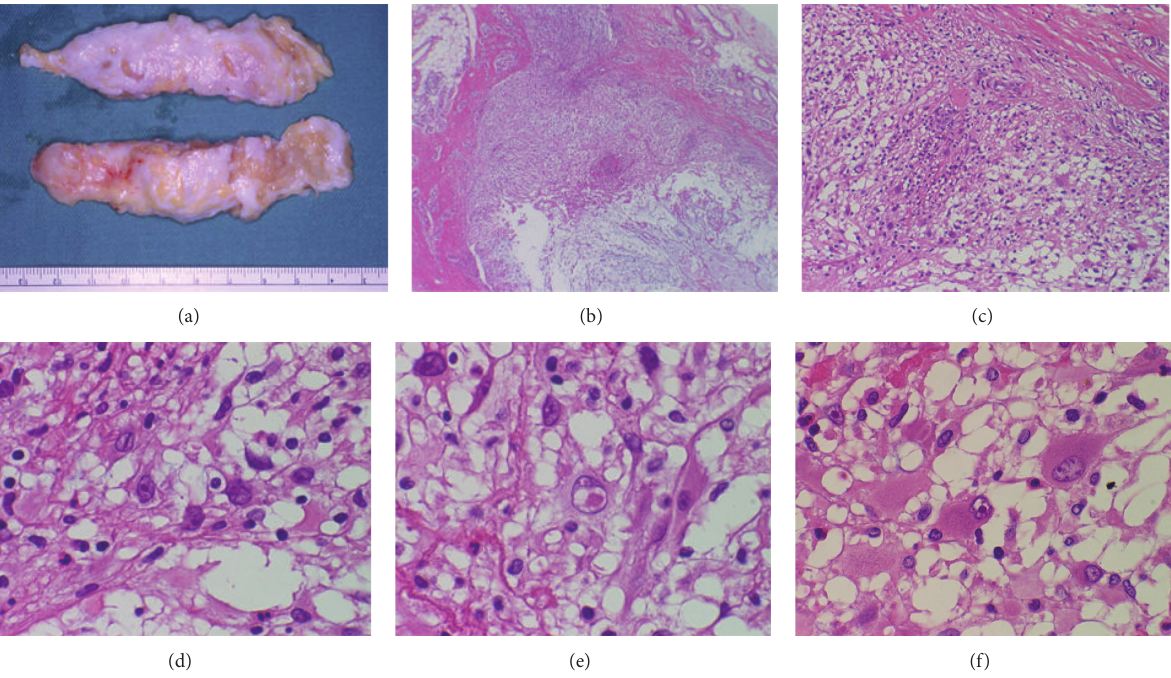
Figure 4: Macroscopic view of the removed tumor (a). Note the multinodular or lobular appearance of the surface. Microscopically, multinodular areas (b) were composed of alternating fibrous and myxoid areas of a proliferation of spindle or oval cells having vesicular nuclei (c) and ample eosinophilic cytoplasm (d) together with occasional larger atypical vacuolated cells, bizarre ganglion-like, Reed-Sternberg-like cells, or Hodgkin-like cells possessing prominent eosinophilic nucleoli ((e), (f)). ((b)–(f)) H&E stain; magnification, (b) × 20, (c) × 50, and ((d)–(f)) ×